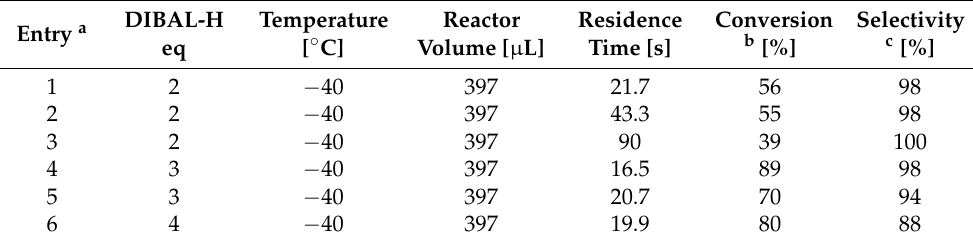
Table 4. Reduction using DIBAL-H in the alternating diameter reactor with different molar